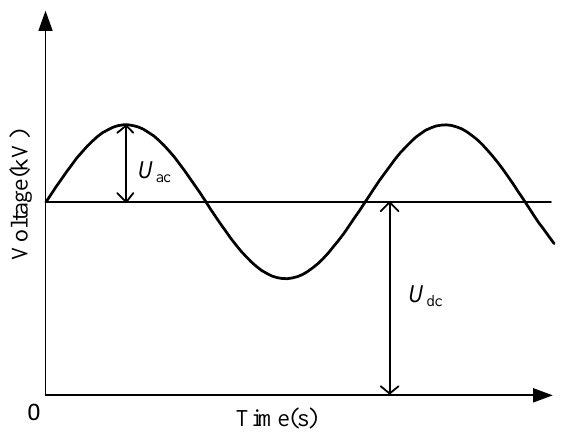
Figure 3. Waveform of AC-DC combined voltage.